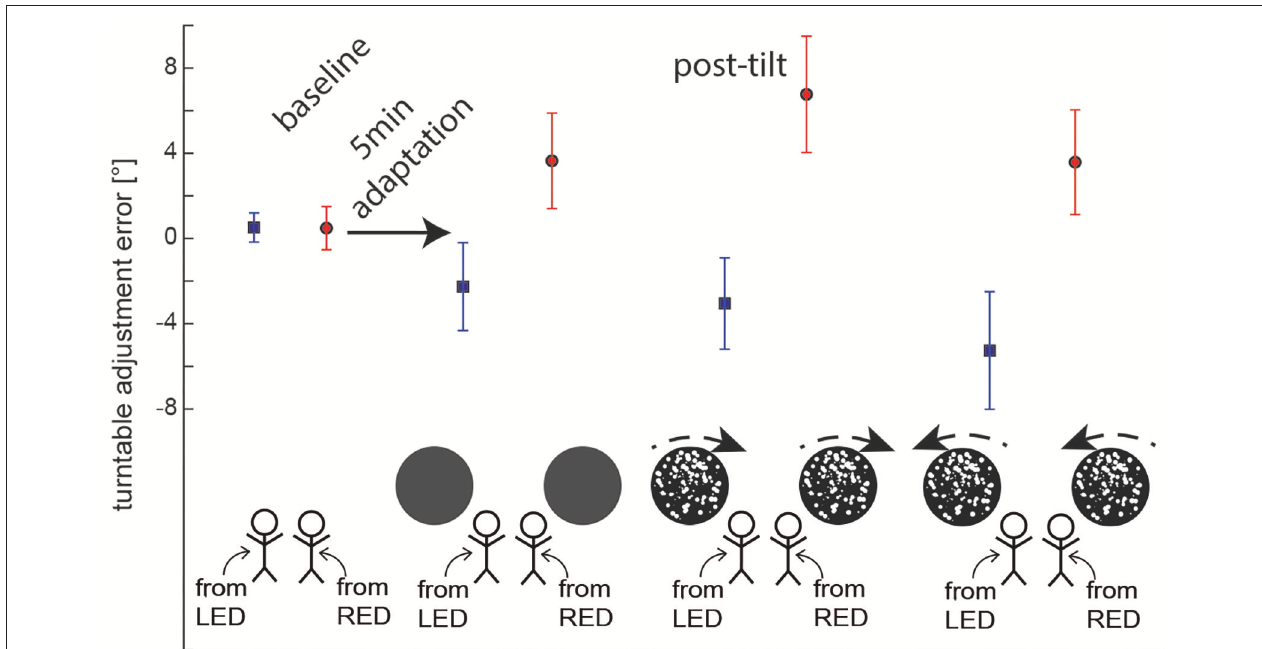
FIGURE 3 | Overall average ( ± 1 SD) turntable adjustment errors are shown for both baseline and post-tilt conditions. For the post-tilt trials the specific adaptation condition (either 90 ◦ left-ear down (LED, lines in blue) or 90 ◦ right-ear-down (RED, lines in red) and the visual background (no optokinetic stimulus, optokinetic CW, optokinetic CCW) is illustrated. Note that in the post-tilt period all trials were collected in total darkness, i.e., no optokinetic stimulation was